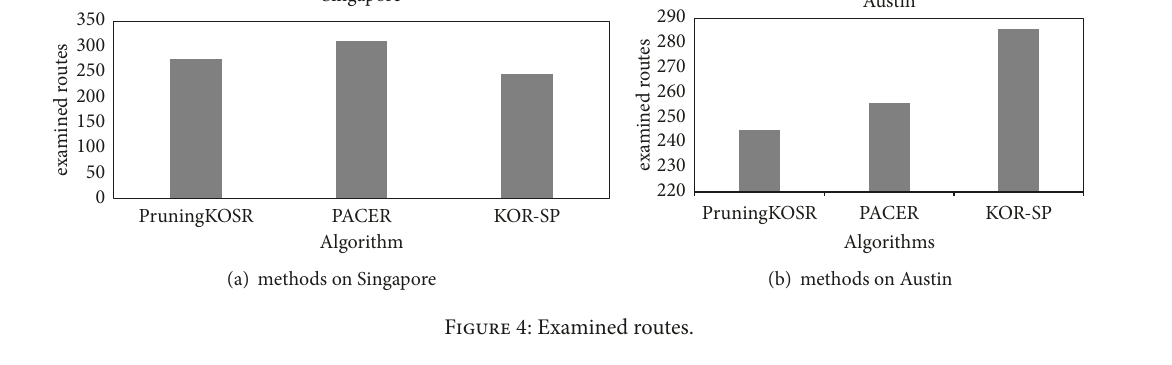
Figure 3: Run-time.